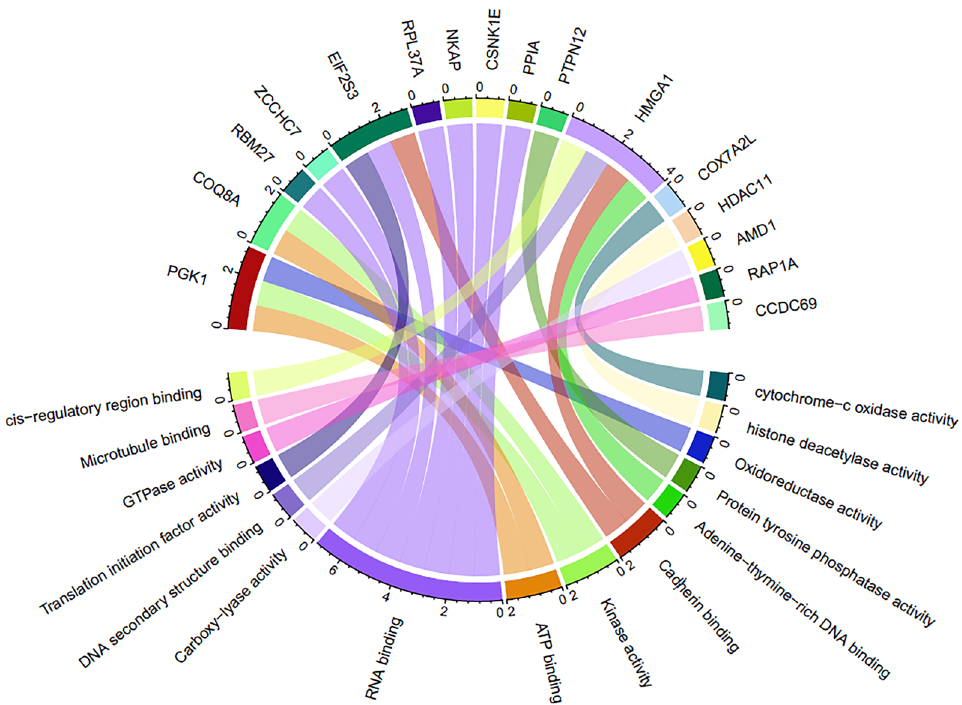
Figure 8. Gene ontology (GO)-molecular function (MF) analysis of the CACNA1G-AS1, NNT-AS1, and MSC-AS1 targeted protein-coding